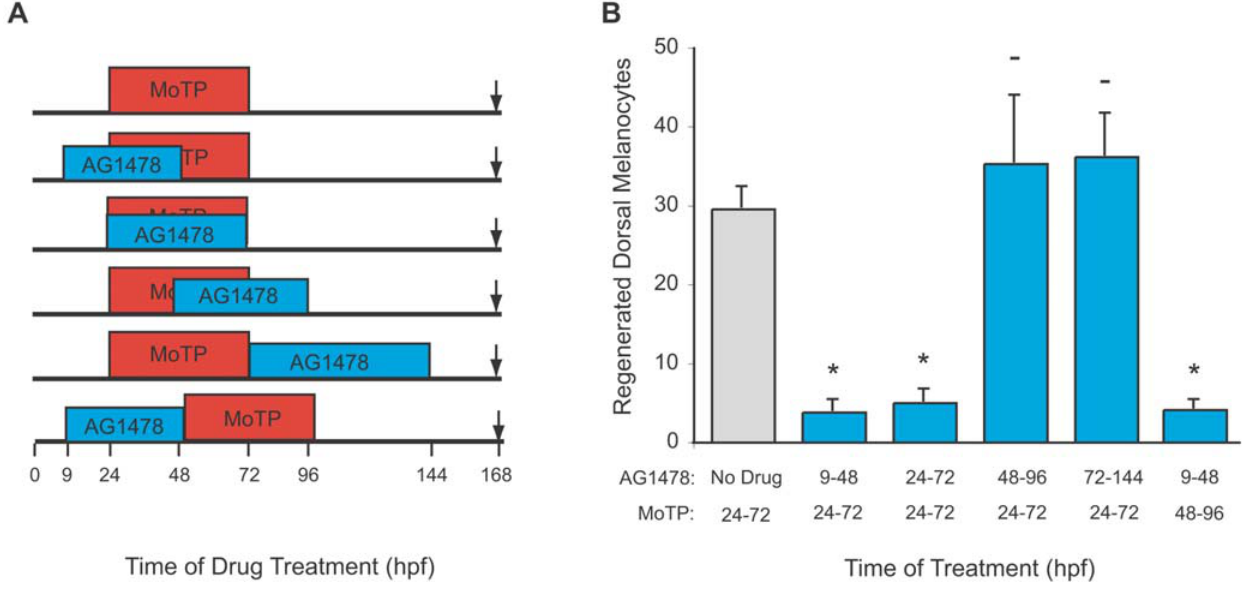
Figure 2. Regeneration requires ErbB signaling before 48 hpf. (A) Cartoon of drug treatment timeline. (B) Quantitation of average regenerated dorsal trunk melanocytes from somites 5–12 for each treatment in (A) for untreated (gray) and AG1478 treated (blue). Error bars represent standard deviation, * P , 0.05, - P . 0.05 (Student t-test, N=10). Time shifts with AG1478 treatment reveal that it blocks regeneration when administered prior to 48 hpf. When AG1478 is added after 48 hpf regeneration is unaffected. The early effect is observed when MoTP treatment is withheld until after AG1478 washout at 48 hpf.